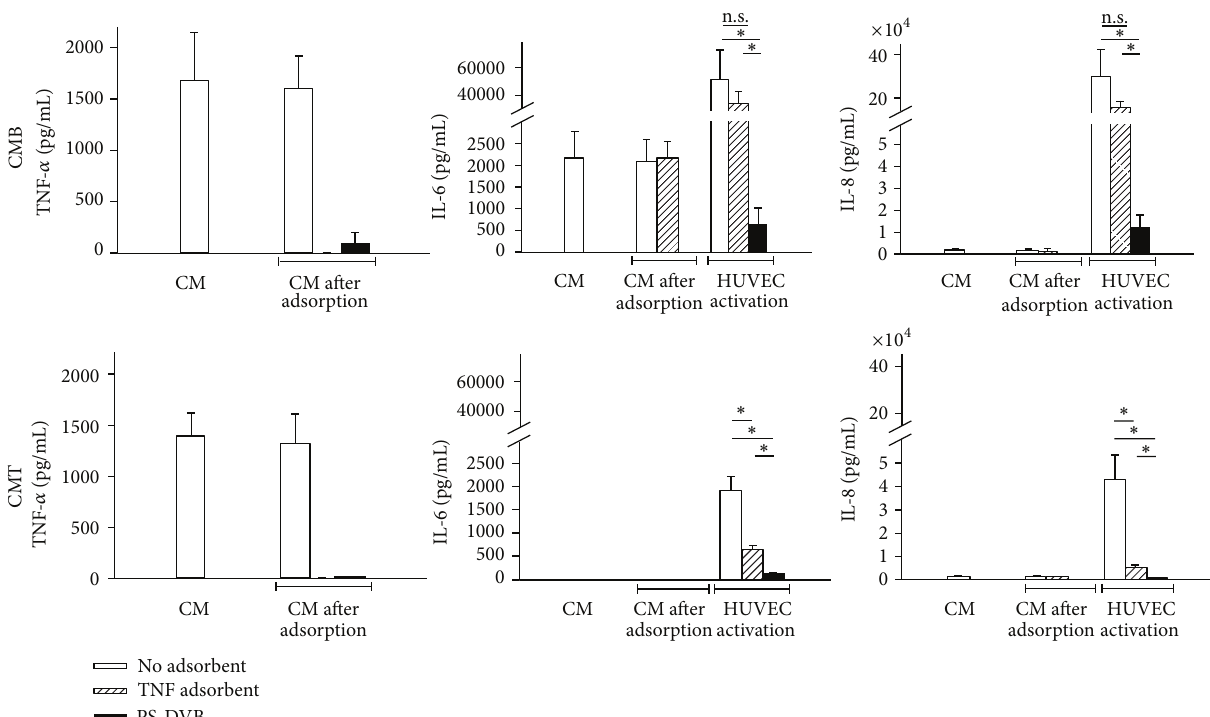
Figure 5: Effect of mediator modulation on HUVEC activation. Whole blood was stimulated with 100ng/mL LPS from E. coli for 4 h and diluted tenfold with M199 to obtain conditioned medium derived from blood (CMB). THP-1 cells were stimulated with 10ng/mL LPS from E. coli for 4h in medium M199 supplemented with 10vol% human plasma to yield conditioned medium derived from THP-1 cells (CMT). HUVEC were stimulated with CMB and CMT, respectively. Concentrations of TNF- 𝛼 , IL-6 and IL-8 prior to mediator modulation (CM) and after specific TNF- 𝛼 adsorption or selective cytokine adsorption (PS-DVB) are shown. Data are given as mean of three experiments ± standard deviation. Significance was accepted at 𝑃 ≤ 0.05 . n.s.: not